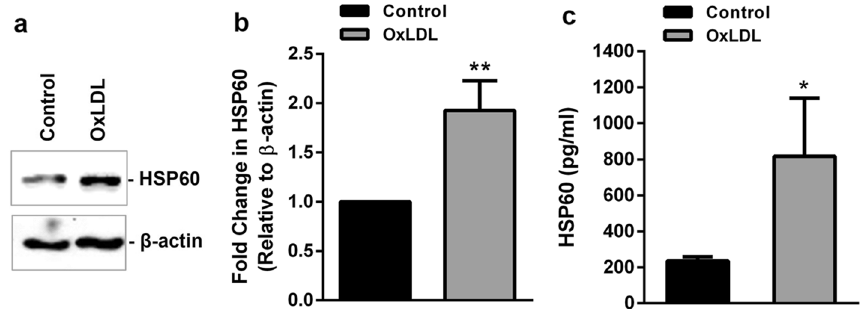
Figure 7. Expression and secretion of HSP60 in OxLDL treated TDMs. TDMs were treated with OxLDL and expression of HSP60 was evaluated by ( a ) western blotting followed by ( b ) densitometry. ( c ) HSP60 secretion was checked in conditioned media by ELISA. Data were expressed as Mean ± SEM (n = 3). *p < 0.05, **p < 0.01, vs untreated control, unpaired two-tailed Student’s